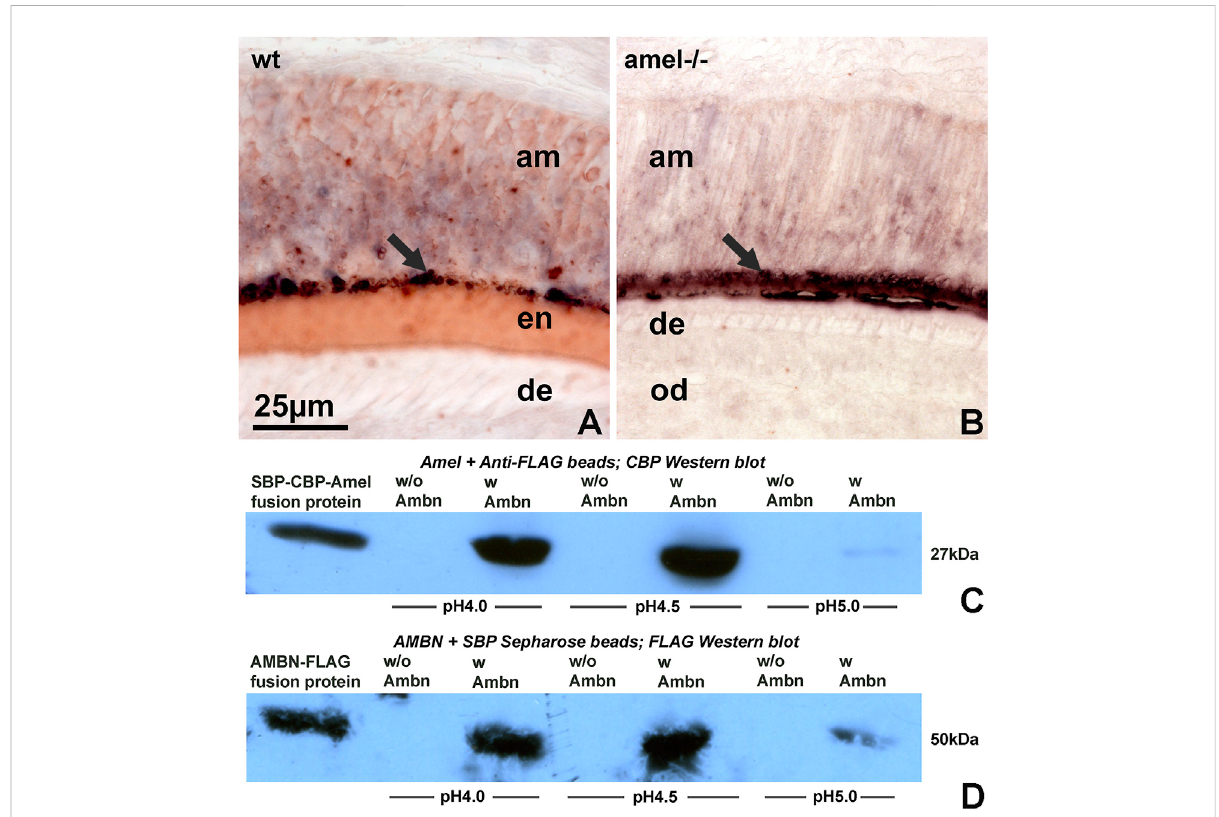
FIGURE 6 AmelogeninandameloblastinenamelmatrixmoleculesinteractatacidicpH. (A,B) Doublestainingforamelogenin(HRPlabeling,redcolor)and ameloblastin (AP labeling, blue/black color) on tissue sections of wild-type (A) and amelogenin null (B) molars. (C,D) Co-precipitation to detect possible interactions between amelogenin and ameloblastin at pH 4, pH 4.5, and pH5. Co-precipitates were either probed with anti-CBP (C, for amelogenin) or with anti-FLAG antibody (D, for ameloblastin). wt = wild-type, amel − / − = amelogenin mutant, am = ameloblasts, en = enamel, de = dentin, od =